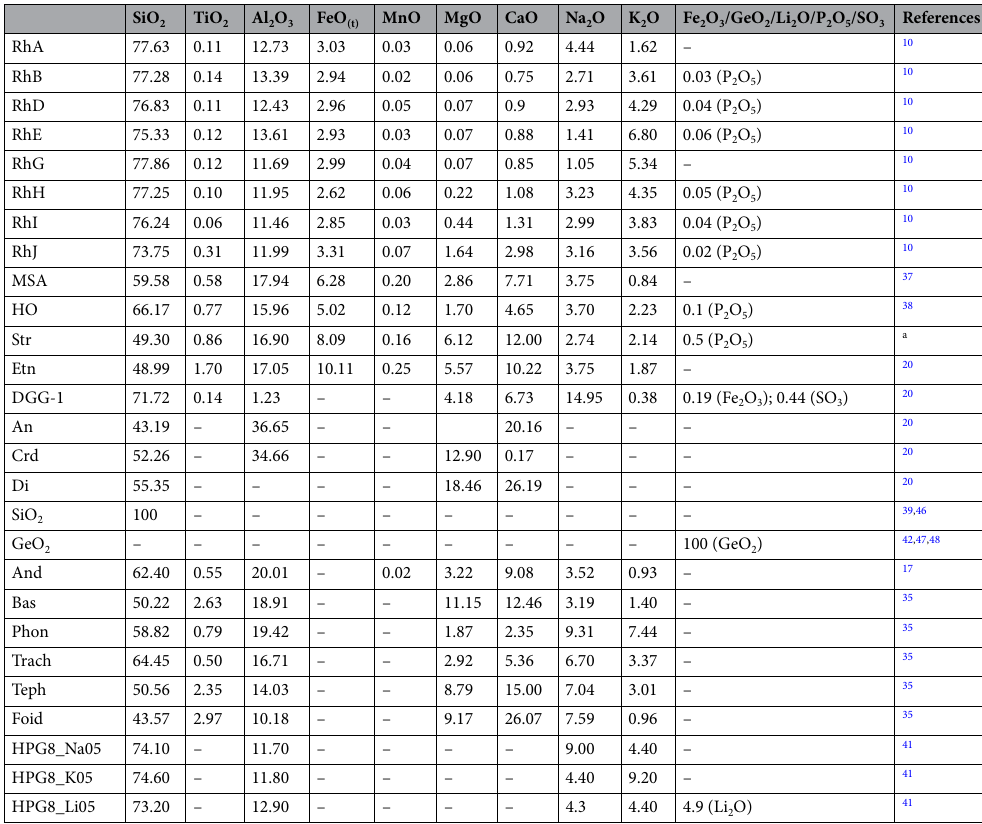
Table 1. Chemical composition (wt%) of samples used and considered in this study. a This